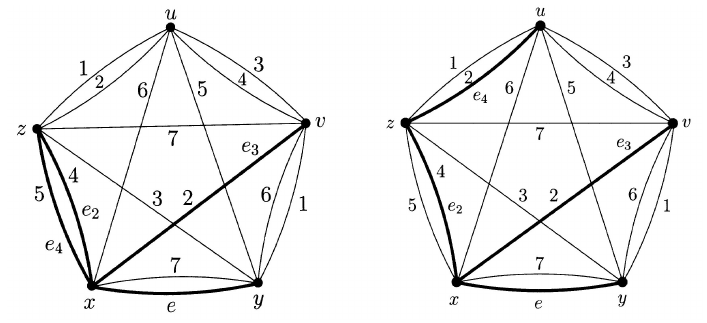
Figure 7: A Vizing-fan and a Tashkinov tree, each with four bold